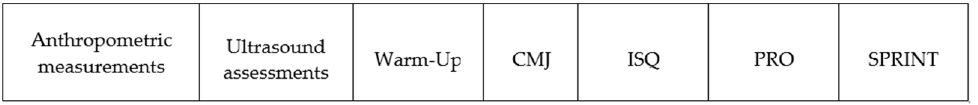
Figure 1. Timeline of the assessments performed. CMJ = countermovement jump; ISQ = isometric squat; PRO = pro-agility test; SPRINT = 30-m dash sprint.